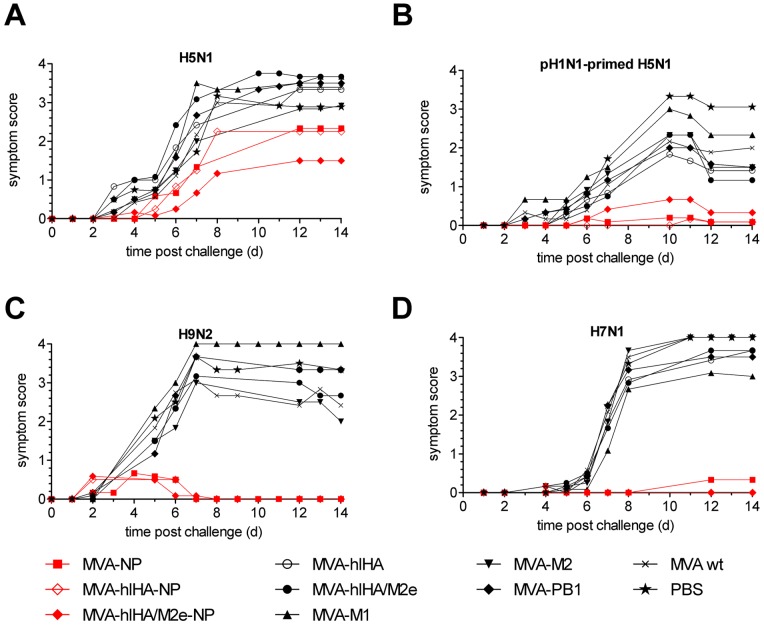
Symptom scores after H5N1, H9N2 and H7N1 challenge.Mice were immunized twice, three weeks apart, with MVA vectors and challenged three weeks later with (A and B) 42 LD50 of H5N1 VN1203, (C) 32 LD50 of mouse-adapted H9N2 HK/G9 or (D) 16 LD50 of H7N1 RO/34. (B) Primed mice were infected intranasally with 100 TCID50 H1N1pdm09 virus, six weeks before immunization. Animals were monitored for 14 days after challenge. Shown are the cumulative mean symptom scores whereby ruffled fur, curved posture, apathy and death were scored as 1, 2, 3 and 4, respectively.